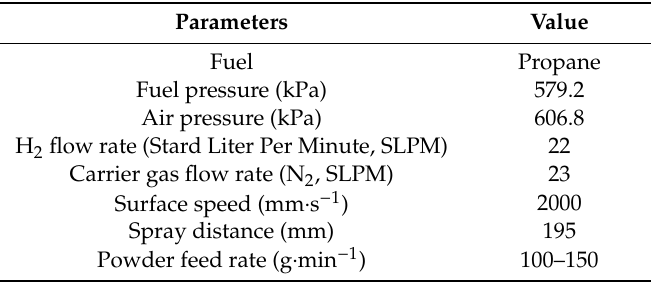
Table 1. Parameters used in the HVAF